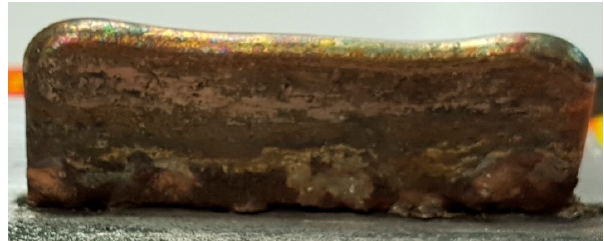
Figure 4. Ti6Al4V wall grown by Laser Melting Deposition (LMD).